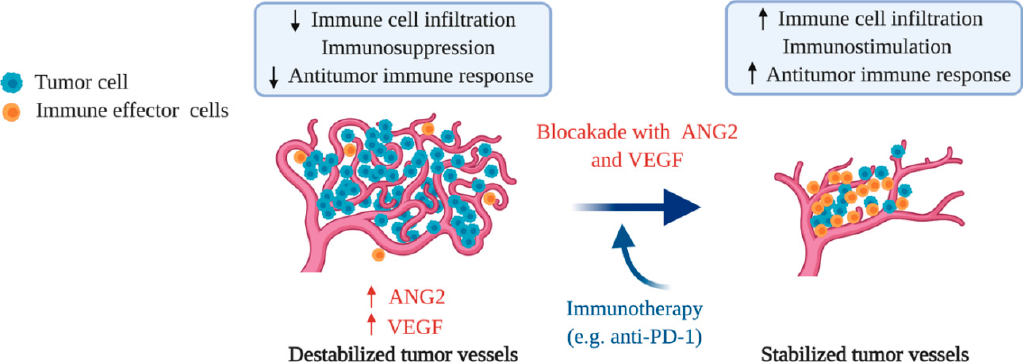
Figure 3. Immunostimulation and enhanced antitumor efficacy of immunotherapy by vascular stabilization. The destabilized vasculature in tumors impairs infiltration of immune effector cells (such as CD8 + T-cells) into the tumor microenvironment, which consequently induces immunosuppression. Vascular stabilization, by targeting the antiangiogenic molecules, ANG2 and VEGF, promotes immune cell infiltration and immunostimulation. Here, immunotherapies such as immune checkpoint inhibitors (ICIs) can further activate suppressed immune effector cells to induce a robust antitumor immune response. This combination treatment modality of antiangiogenic drugs with immunotherapy maximizes therapeutic efficacy in cancer treatment, especially during advanced stage disease.